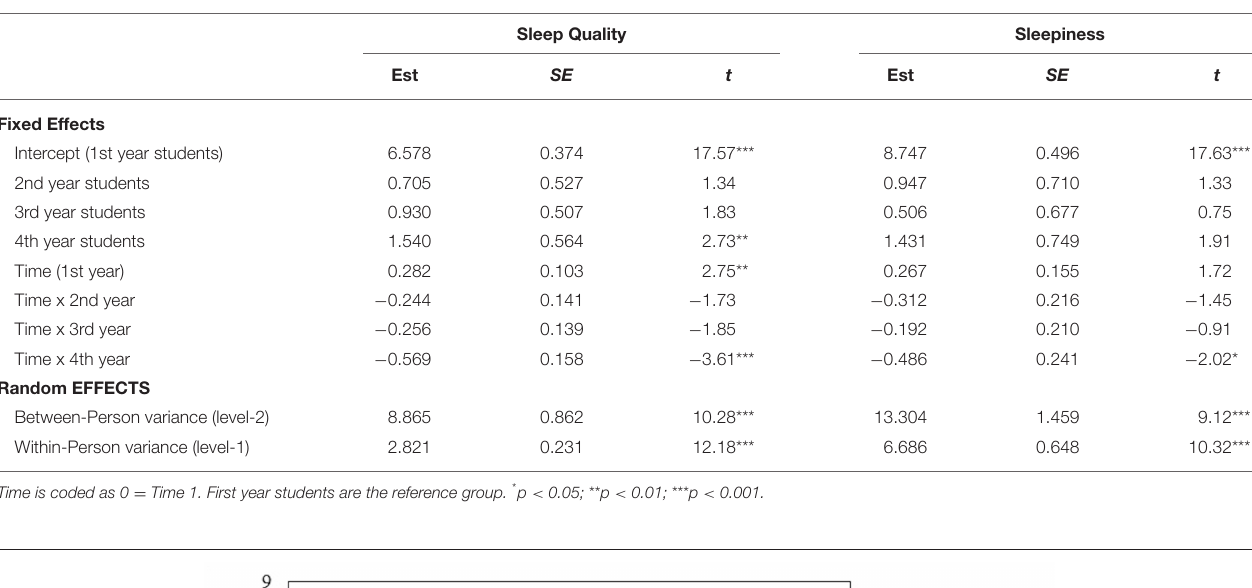
TABLE 3 | Parameters estimates for models predicting sleep quality and sleepiness across the academic year.